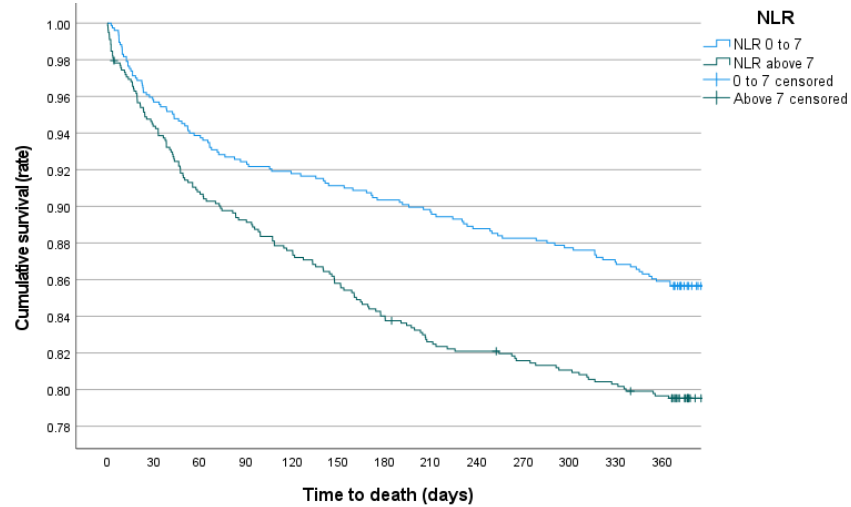
Figure 3. Kaplan-Meier survival function: All-cause mortality following proximal femur fracture fixation surgery in an elderly population ( p < 0.001).